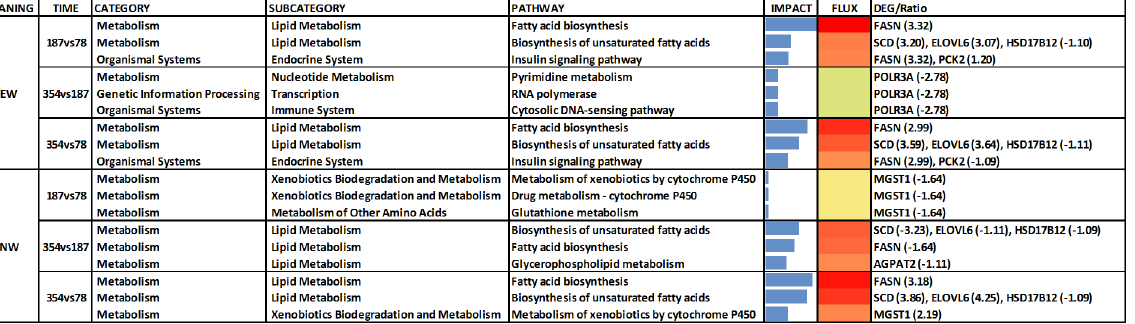
Fig 4. Results of the 3 most impacted pathways within differentially expressed genes affected during the growing phase (187 vs. 78 d), finishing phase (354 vs. 187 d) and the whole experiment (354 vs. 78 d). Analysis performed using the Dynamic Impact Approach (DIA) based on the Kyoto Encyclopedia of Genes and Genomes (KEGG) Pathways database. Flux represents the direction of each category and the corresponding subcategory (green color = inhibition, yellow color = stable, red color = activation with different color intensities according with the level of up-regulation or down- regulation). Blue bars denote the impact of each biological